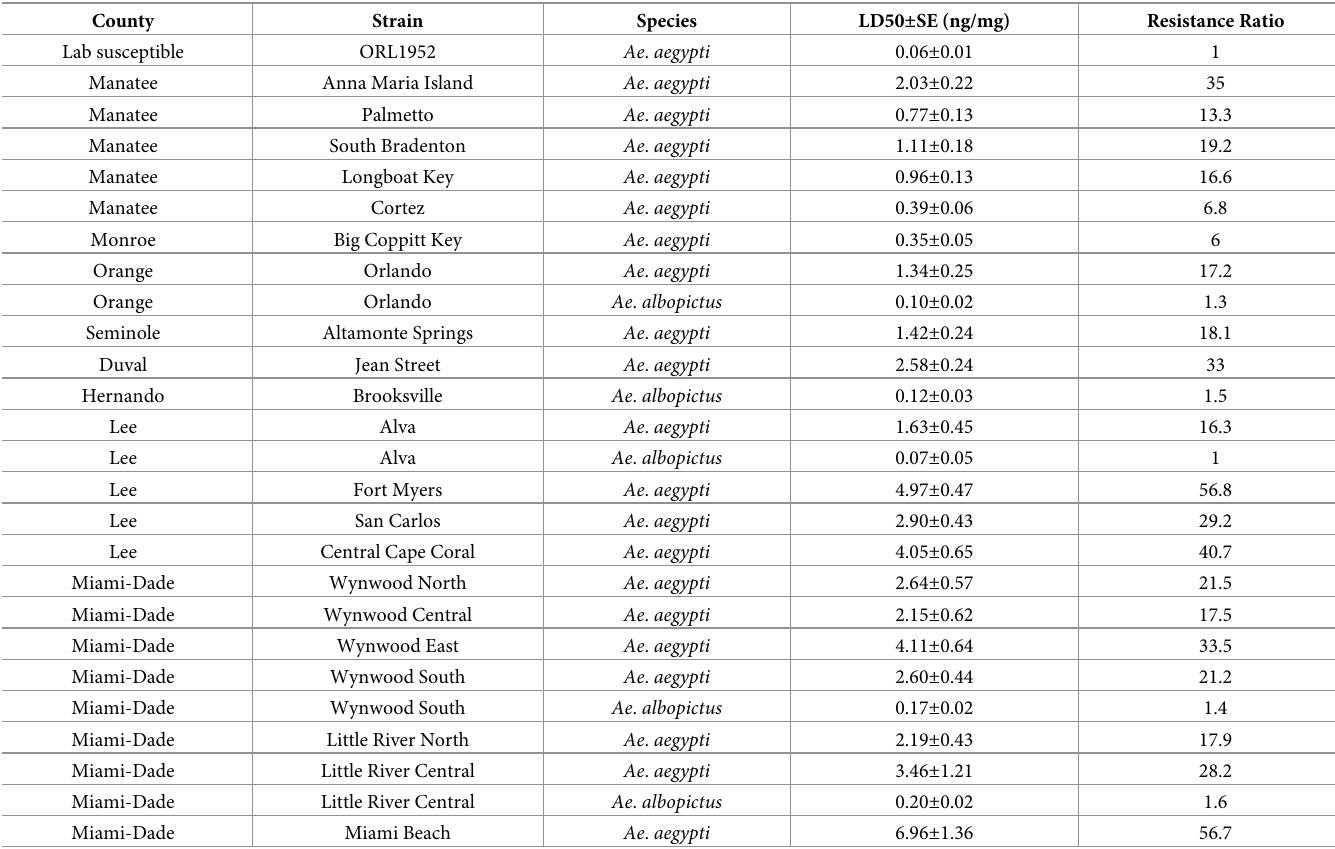
Table 3. Permethrin resistance ratios of select Florida strains of Aedes aegypti and Ae . albopictus calculated from direct topical application. County